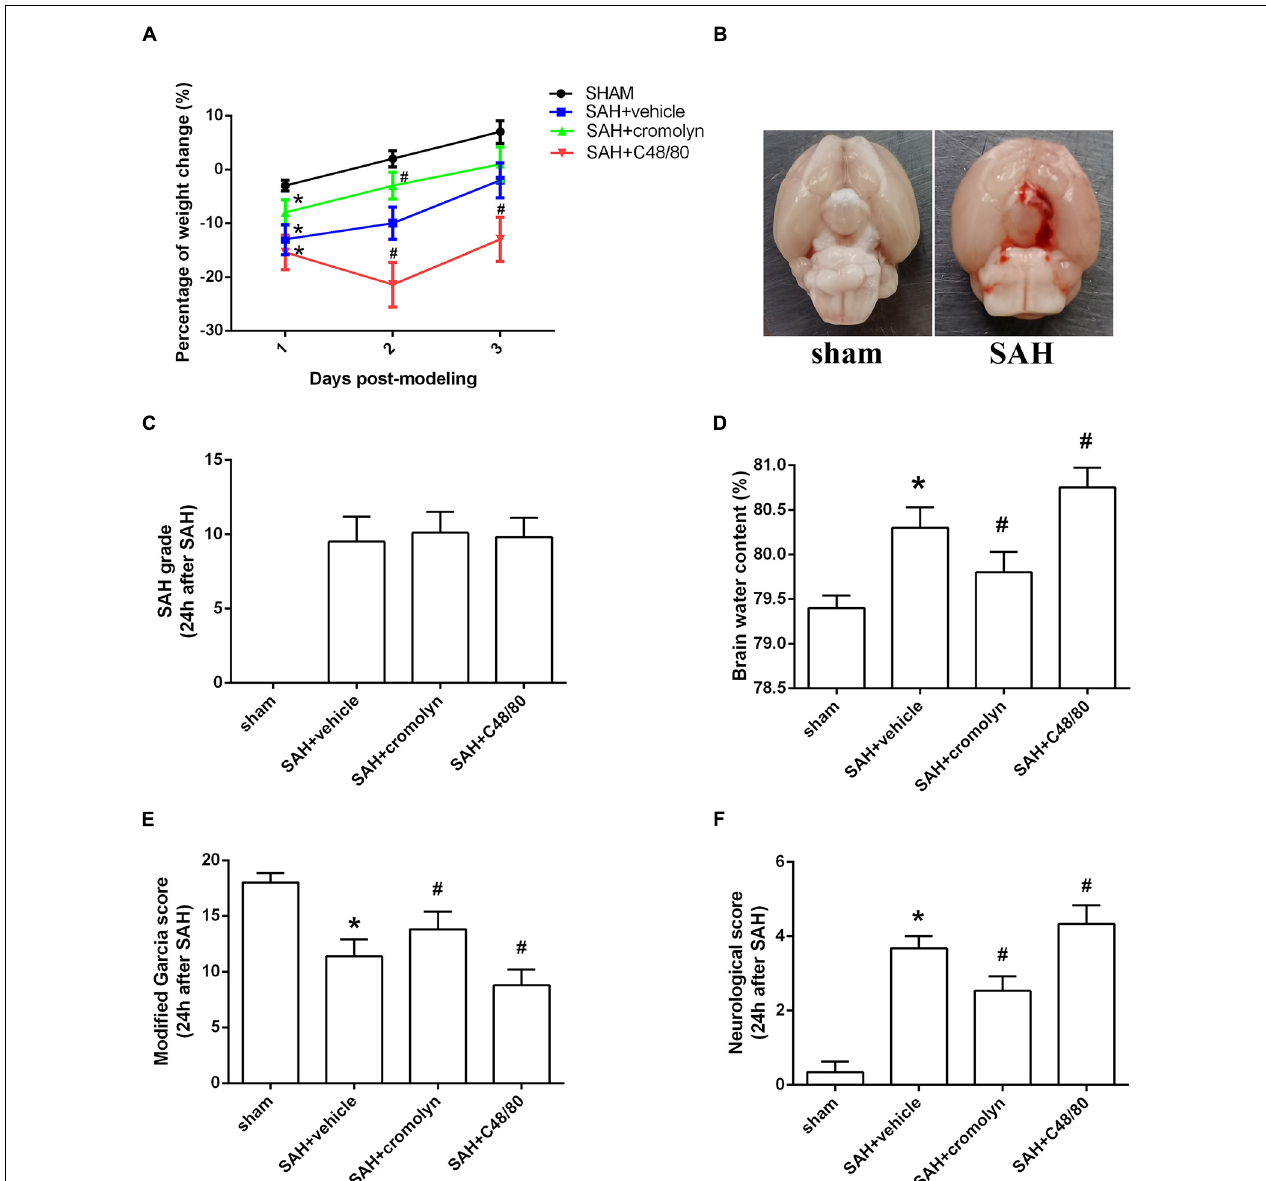
FIGURE 3 | Effect of MCs on brain edema and neurological outcome at 24 h post-modeling. (A) The change of body weight in animals among different groups. (B) Typical brains from sham-operated and SAH mice. (C) The quantification of SAH severity. (D) The quantification of brain water content. (E,F) The quantification of neurobehavioral test. n = 6. Data are represented as mean ± SD. * P < 0.05 versus sham group. # P < 0.05 versus SAH + vehicle